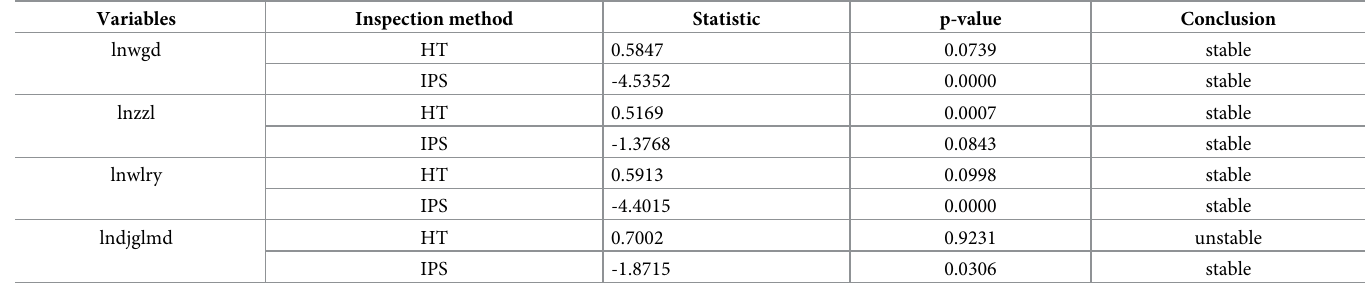
Table 18. Description of unit root test results of variables.